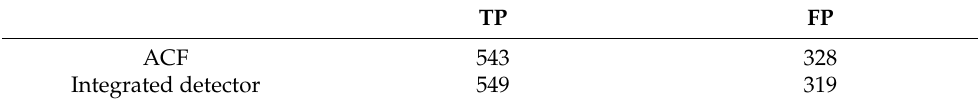
Figure 20. Miss rate versus FPPI for the ACF detector and the proposed integrated detector on the INRIA pedestrian test set.